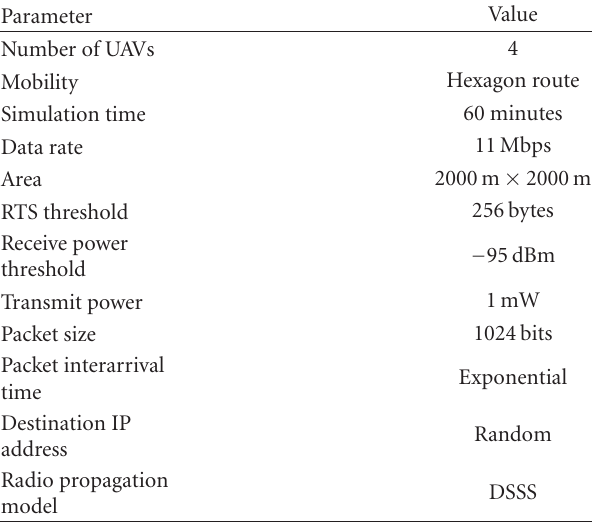
Table 6: Simulation